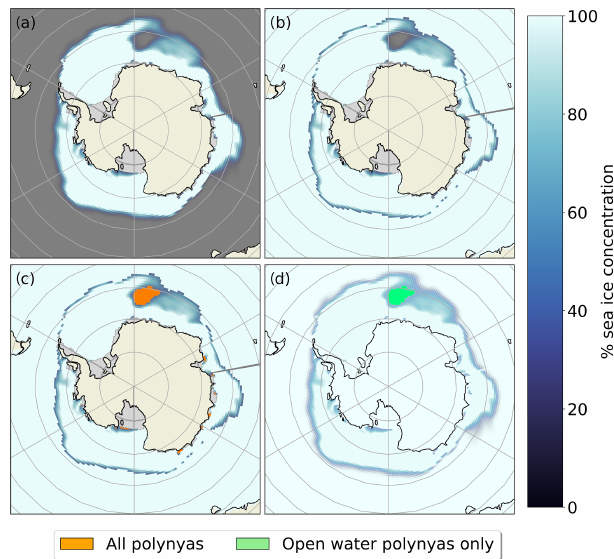
Figure 1. A four-step algorithm classifies surface type areas in the marginal ice zone. (a) August 2002 monthly mean sea ice concen- tration from ACCESS-ESM1.5. (b) Sea ice map after covering the open ocean with the flood fill algorithm. (c) Application of a thresh- old filter, highlighting the total polynya areas. (d) Flood fill algo- rithm is applied to Antarctic fast land; the remaining open water or low sea ice areas are classified OWPs. The ice shelves appear in light grey and the ocean in dark